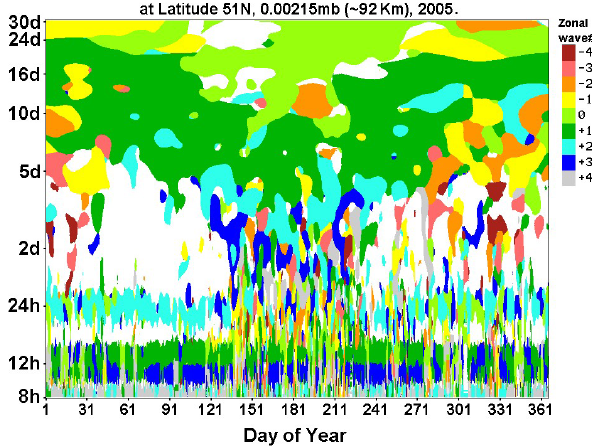
Fig. 7. A wavelet-format plot based on the analysis used in Fig. 1, but showing the wave number in the range − 4 to +4 with greatest significance at each